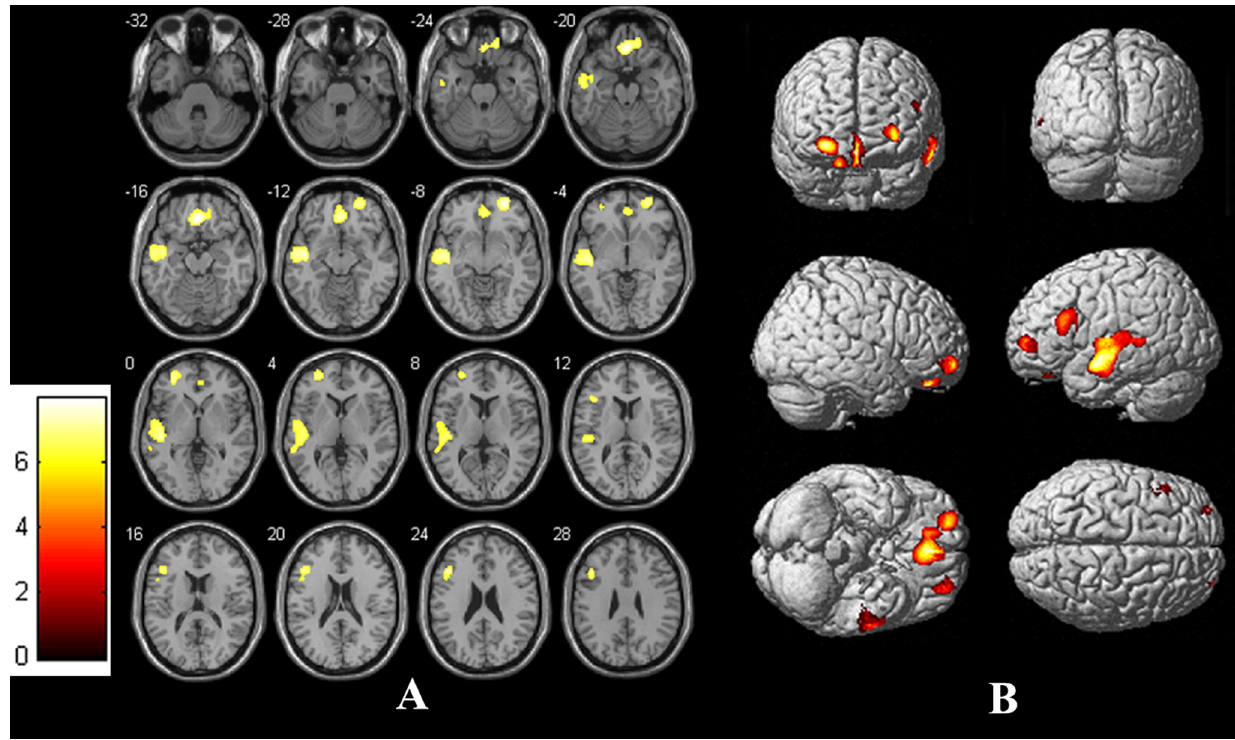
Figure 1. Statistical Parametric Images of Voxel-Based Morphometry Analysis for ESRD Patients and controls (Panels A: slices view, Panels B: whole brain rendering). Relative to controls, ERSD patients had significantly reduced gray matter volume in the bilateral medial orbitofrontal cortex, bilateral dorsal lateral prefrontal cortex and right middle temporal gyrus.